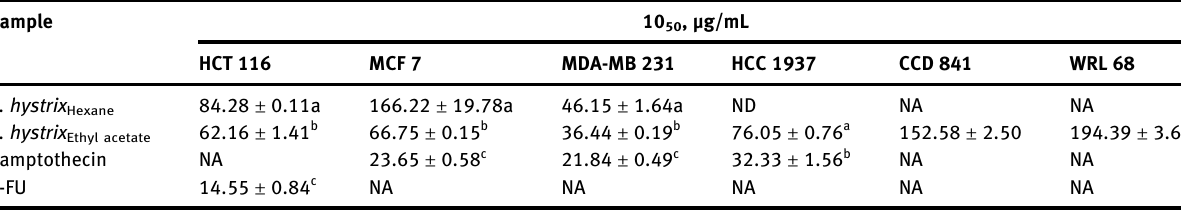
Table  : Cytotoxicity analyses of the ethyl acetate and hexane extracts of C. hystrix against colon cancer cell line; HCT  and breast cancer cells lines; MCF  , MDA-MB  and HCC  .